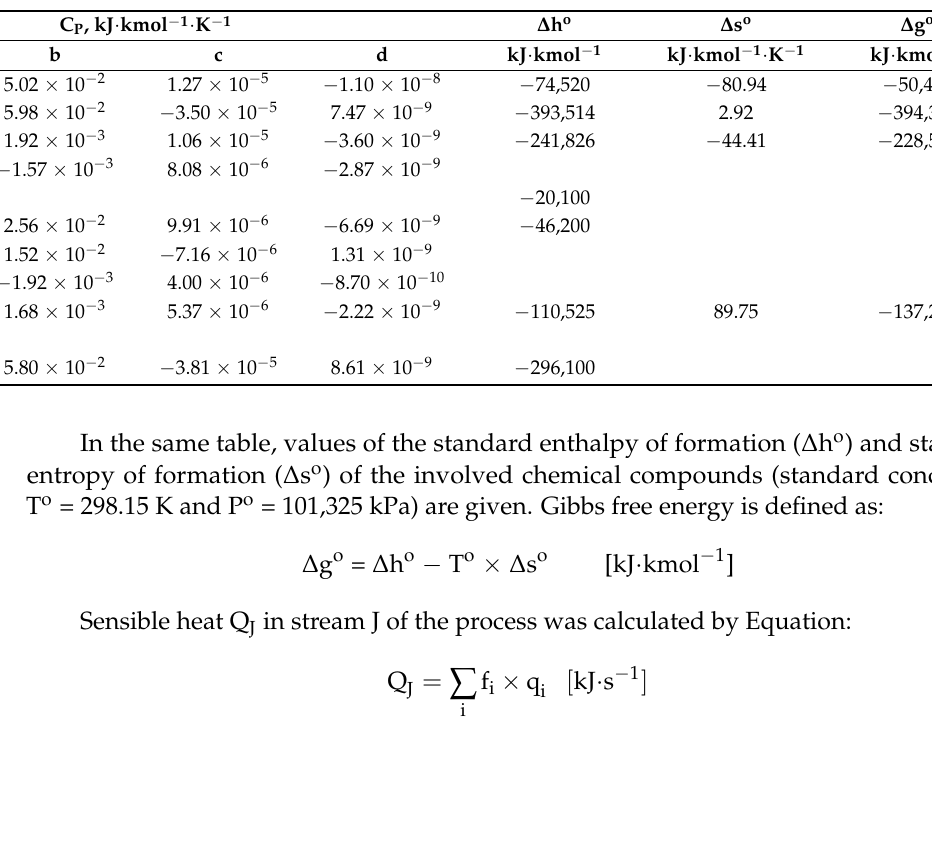
Table A1. Thermodynamic values